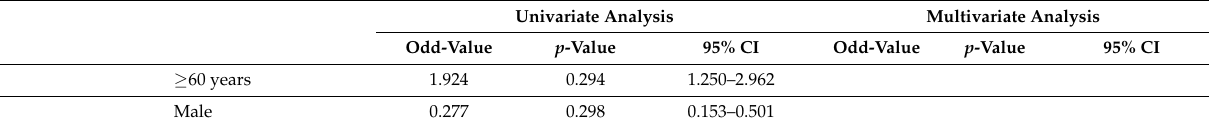
Table 4. Analysis of risk factors for CP progression from